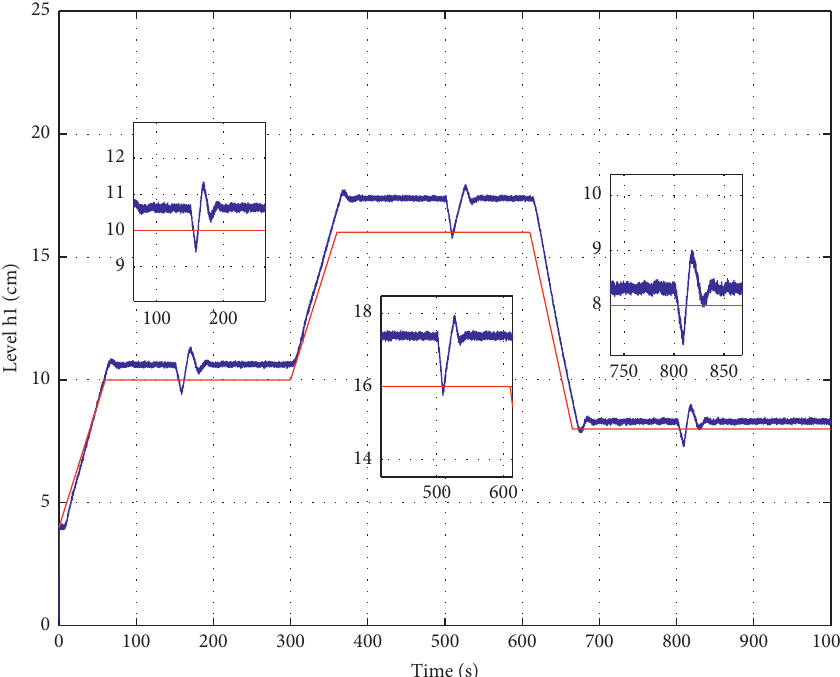
Figure 10: Experimental result of tracking by BC and impact on parameter